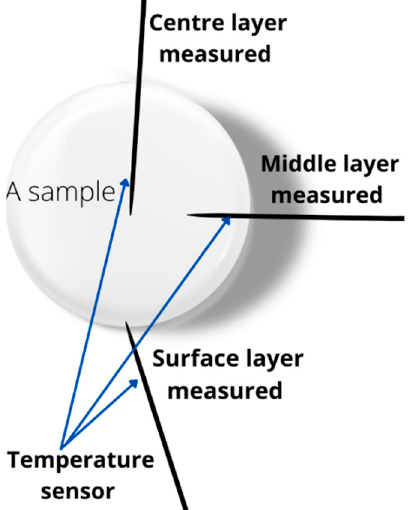
Figure 3. Temperature measurement positions inside a sample.